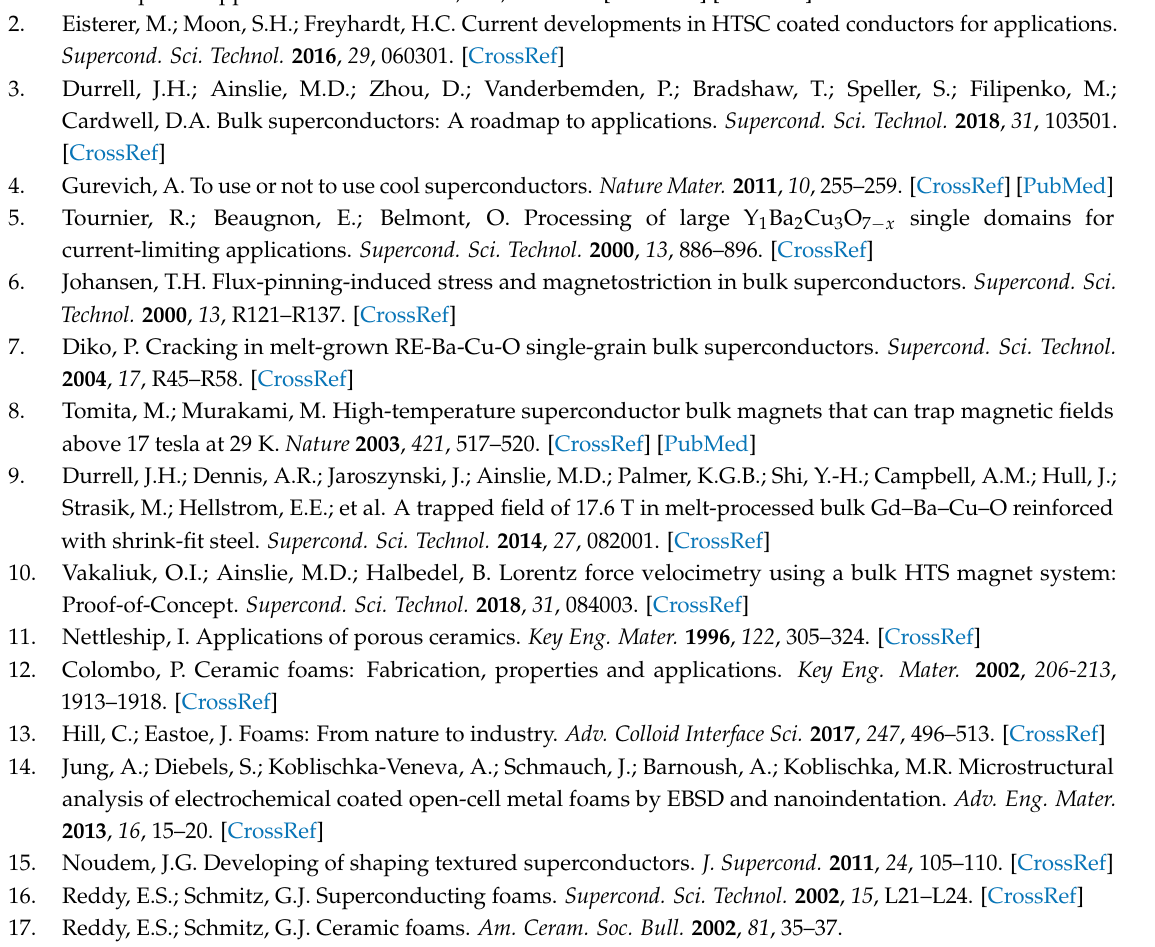
Figure S1: YBCO foam sample being pushed while levitating on a magnetic rail, Figure S2: Superconducting foam levitating above a magnetic rail. (a) Foam sample running at full speed on the rail, and (b) foam sample when being close to warm-up, Video S1: Demonstration of levitating foam